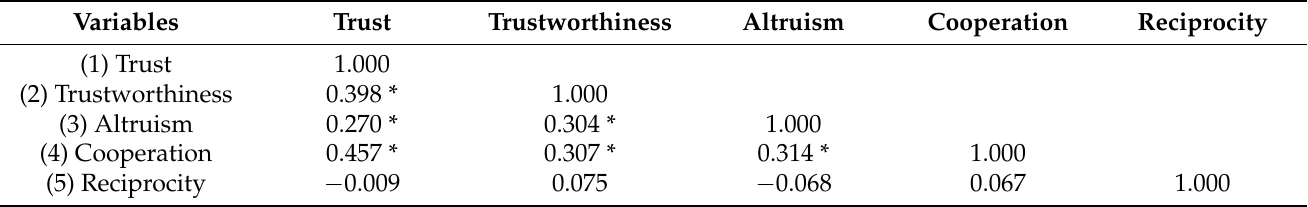
Table 2. Pairwise correlation between experimental trust measures with Bonferroni correction . Variables Trust Trustworthiness Altruism Reciprocity